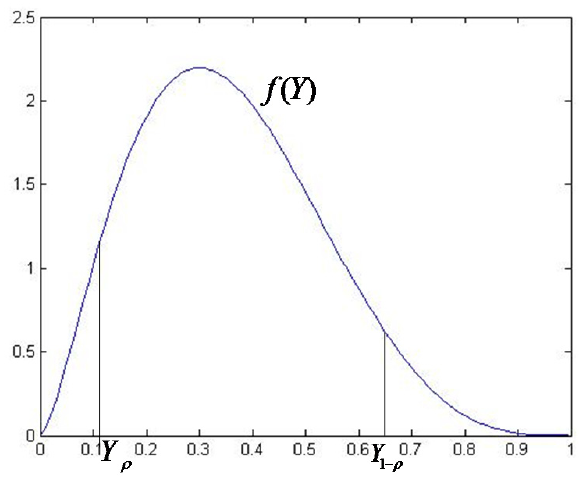
Figure 5. The Beta distribution curve.